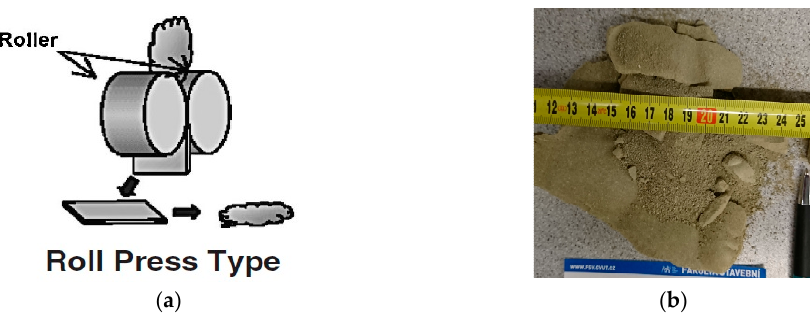
Figure 3. ( a ) sketch of the compaction machine [9] used by the producer of the granulated bentonite (Keramost Plc.; Žatecká 1899/25; CZ 434 30; Most, The Czech Republic); ( b ) the B75 REC bentonite material (plates up to approx. 15 cm in length).